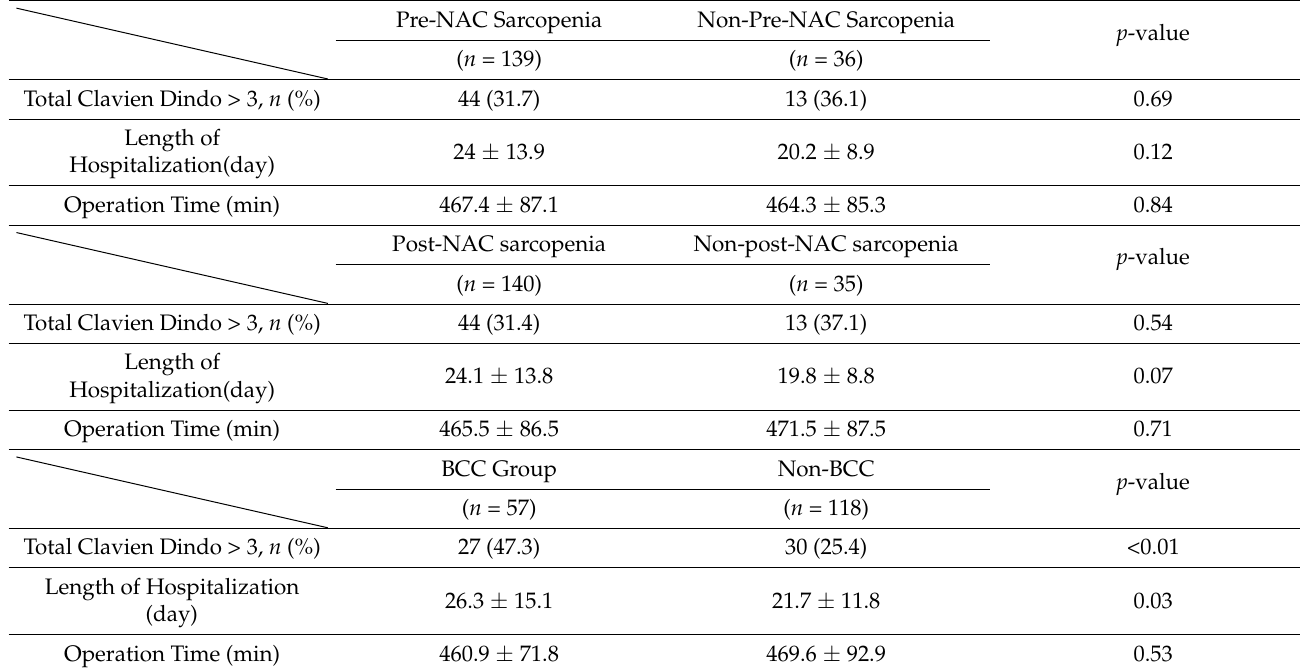
Table 5. Comparison of perioperative complications, operative time, and hospital stay in pre- and post-NAC sarcopenia, and BCC group.